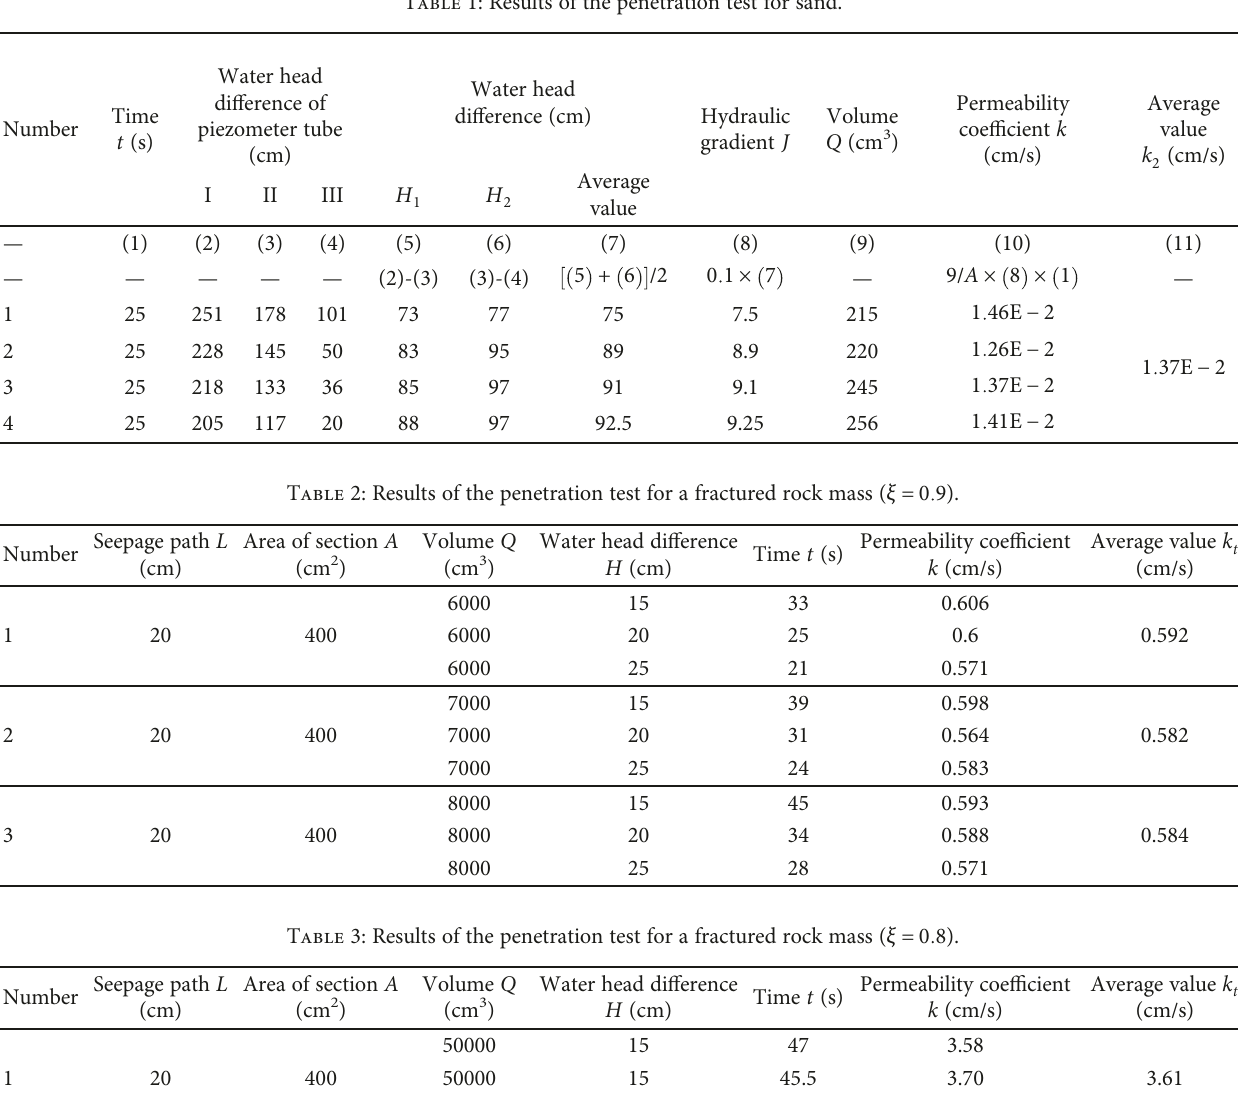
Table 1: Results of the penetration test for sand.